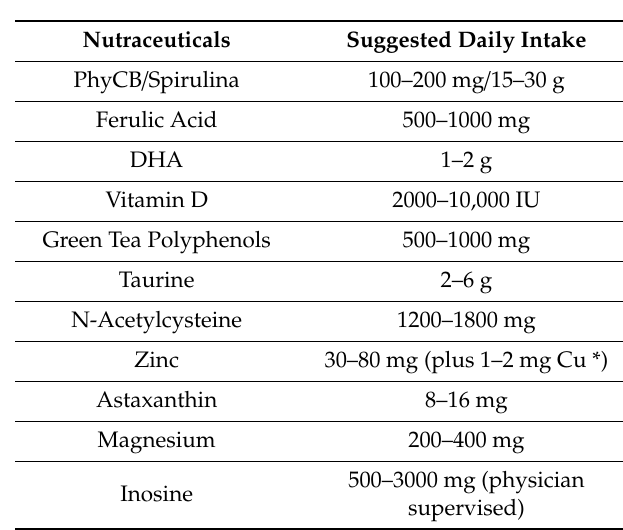
Table 1. Nutraceuticals with potential for prevention / control of Parkinson’s disease. Suggested daily intake